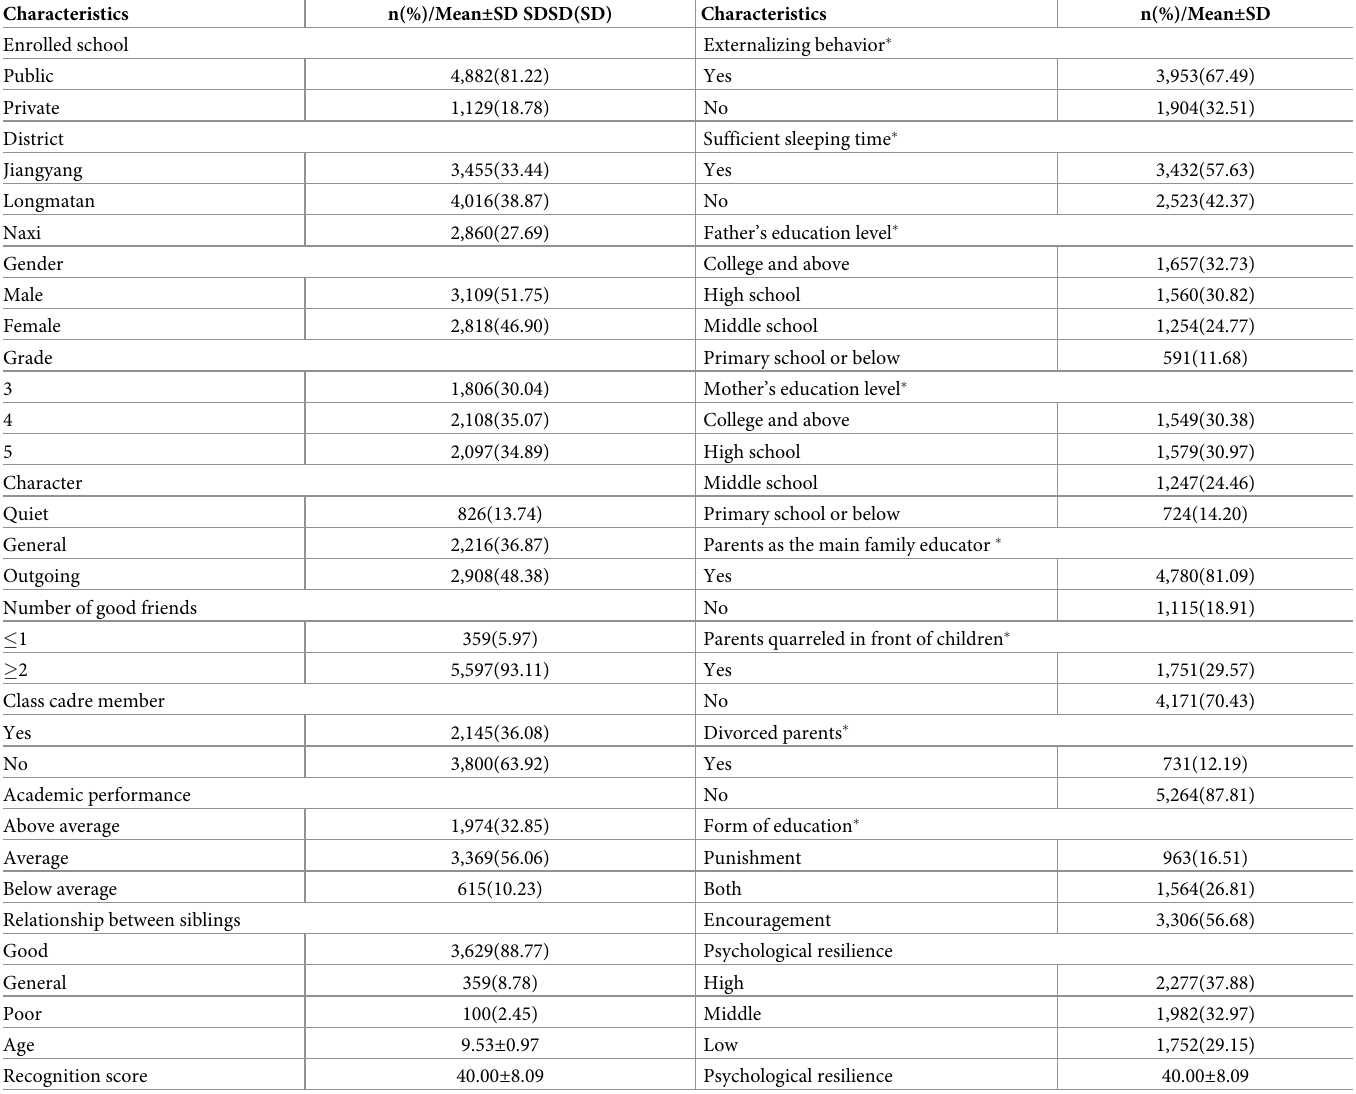
Table 1. Characteristics of the participants from Luzhou City, China n(%)/Mean ± SD.